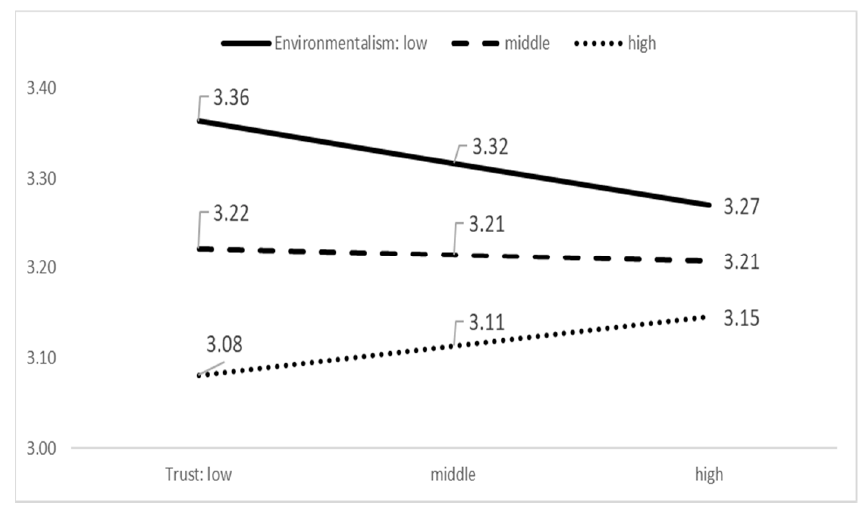
Figure 8. Trust (IV) × environmentalism (M) = skepticism (DV).